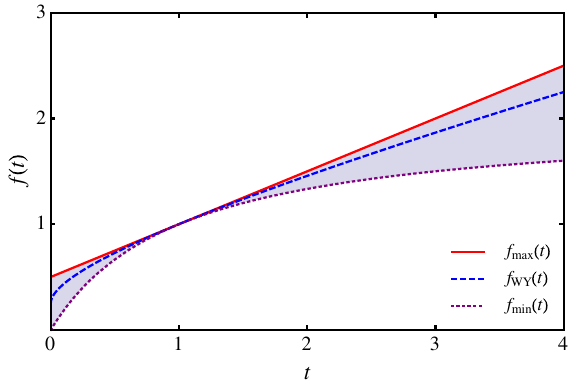
FIG. 2. The family of MC functions is upper bounded by a t Þ ¼ ð 1 þ t Þ = 2 , corresponding to the quan- maximal one, f max ð tum Fisher information metric (red solid line), and lower bounded t Þ ¼ 2 t= ð 1 þ t Þ (purple dotted line). Any by a minimal one, f min ð t Þ ≤ f ð t Þ ≤ f t Þ ; i.e., its graph MC function f ð t Þ satisfies f min ð max ð falls into the shaded area, as shown in the particular case of ffiffi p t Þ ¼ ð 1 = 4 Þð t the MC function f þ 1 Þ 2 corresponding to the WY ð Wigner-Yanase information metric (blue dashed line). All the MC functions collapse to 1 at t ¼ 1 . This reflects the fact that the corresponding Riemannian metrics are regular on the maximally mixed